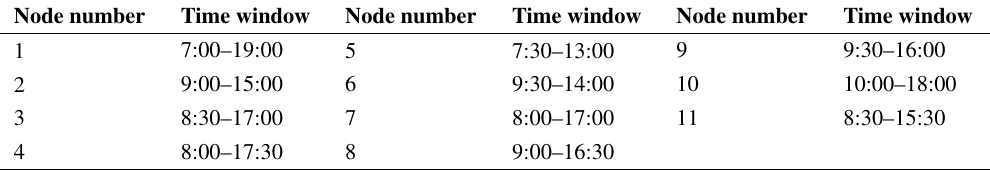
Table 3 Time windows of semi-trailer distribution points in each urban node